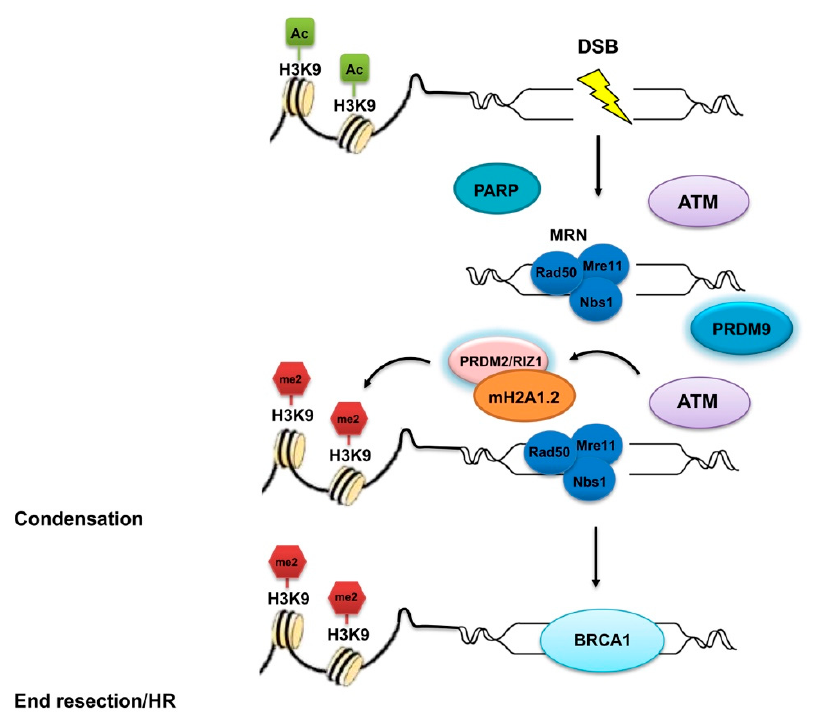
Figure 4. Involvement of PRDM proteins in double-strand break (DSB) DNA repair. Many insults are responsible for DNA double-strand breaks (DSBs) that impair DNA replication and proper chromosome segregation. DSB repair system disfunction is frequently observed in cancer, thus rendering cells prone to transformation. PRDM2 / RIZ1 and PRDM9 are implied in the DSB repair complex, which is essential for ensuring accurate DNA repair and maintenance of genomic integrity. First, PARP is recruited at the DSB where it catalyzes the formation of poly (ADP-ribose) chains, facilitating the docking of the MRN complex to the DSB. The MRN complex, with its nuclease activity and DNA binding capability, is involved in the initial processing of DSBs. Subsequently, ataxia telangiectasia mutated (ATM) kinase induces the recruitment of the mH2A1.2 / RIZ1 complex at DSB sites. PRDM2 / RIZ1 induces the H3K9me2 and in that way enables a dynamic switch in chromatin conformation. Finally, the mH2A1.2 / RIZ1 module recruits BRCA1. PRDM9 also a ff ects the DSB initiation and repair, thus allowing genetic exchange between